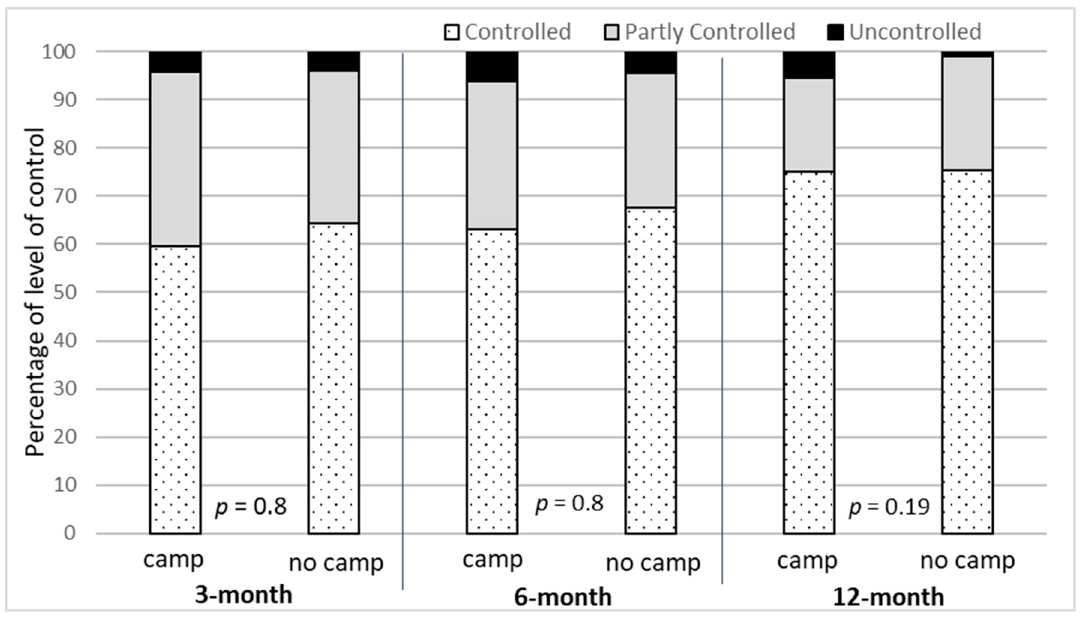
Figure 2. Level of asthma control for children who did/did not attend an asthma education camp. Table 4. PAQLQ score distribution by level of asthma control at each follow-up